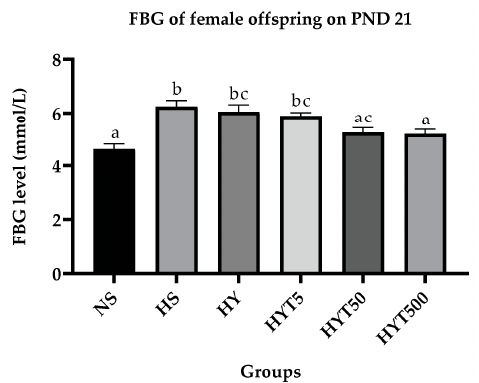
Figure 5. Level of fasting blood glucose in female offspring on PND 21. NS: normal chow and saline; HS: HFD and saline; HY: HFD and yoghurt; HYT5: HFD and 5 mg/kg of E. tapos yoghurt; HYT50: HFD and 50 mg/kg of E. tapos yoghurt; HYT500: HFD and 500 mg/kg of E. tapos yoghurt. Values are expressed as mean ± SEM. Different letters indicate a significant difference at p < 0.05.